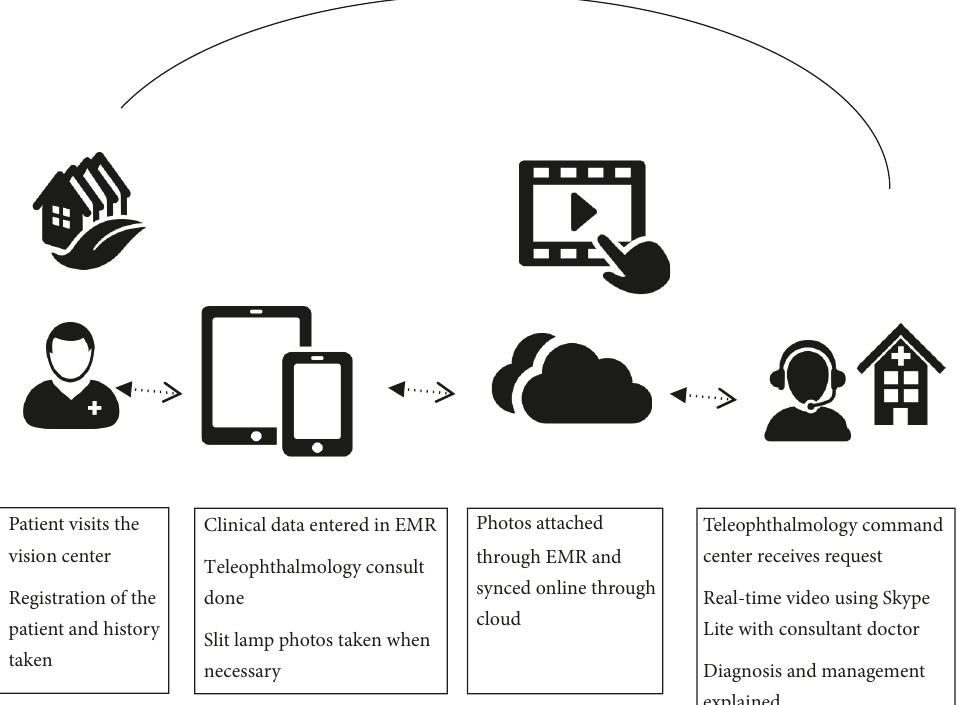
Figure 18: Steps in a vision